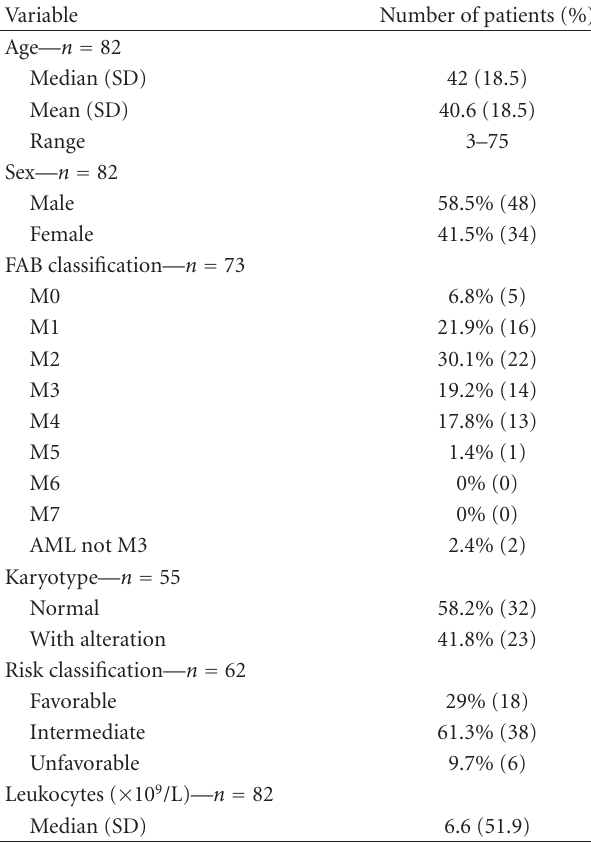
Table 3: Characteristics of the entire patient population.